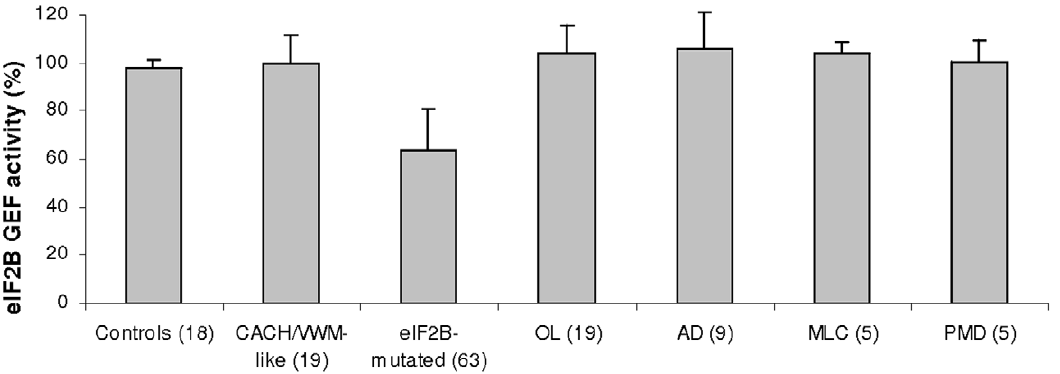
Figure 2. Decreased eIF2B GEF activity in eIF2B-mutated patients’ lymphoblasts (LLB). The eIF2B GEF activity was measured in LLB from 63 eIF2B-mutated patients in comparison to 8 healthy controls, 19 patients carrying other leukodystrophies (OL: 9 patients with Alexander disease, AD, 5 patients with Pelizaeus-Merzbacher disease, PMD, and 5 patients with Megalencephalic leukoencephalopathy with cysts, MLC), and 19 CACH/VWM-like patients without eIF2B mutations. Experiments were carried out in triplicate. Data are presented as percentage of exchange activity of control LLB. The statistical multiple comparisons analysis between all the seven groups showed significant differences (*) only for the eIF2B-mutated group (p , 0.001).